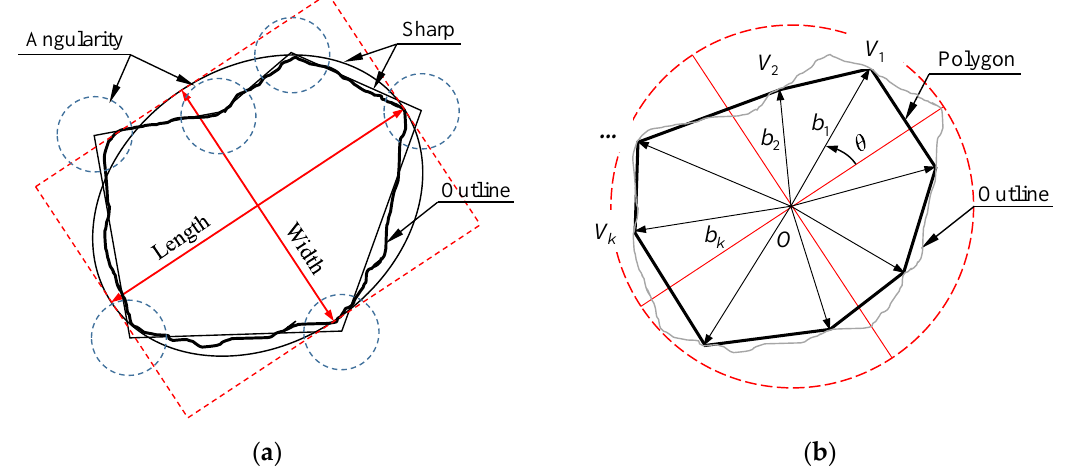
Figure 5. Description of particle morphology: ( a ) rock outline; ( b ) irregular polygon.